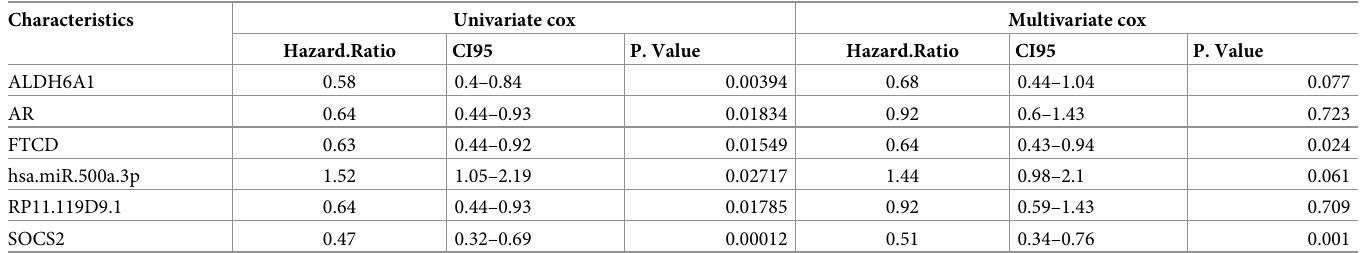
Table 1. Identify the biomarkers to predict prognosis based on multiple variate COX model.